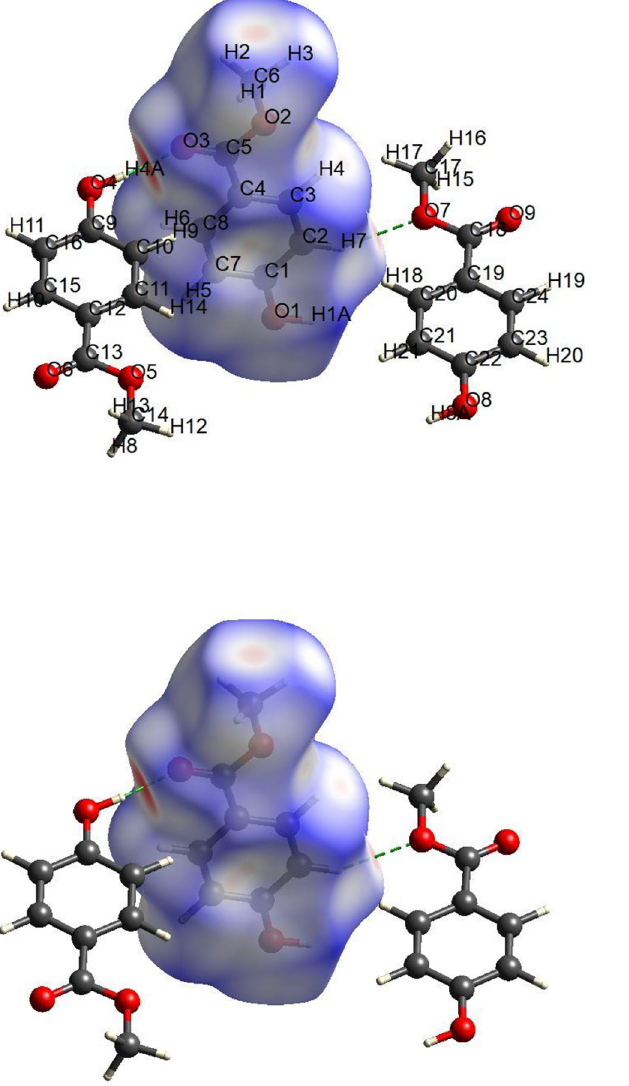
Fig 2. The Hirshfeld surface of the compound mapped with